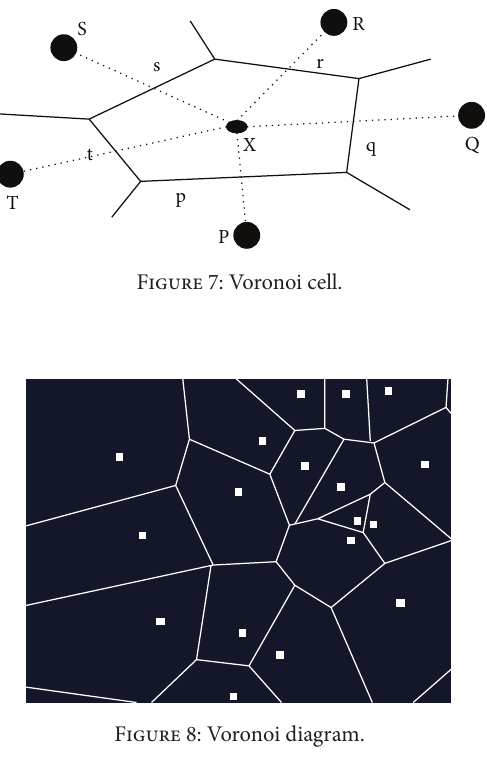
Figure 8: Voronoi